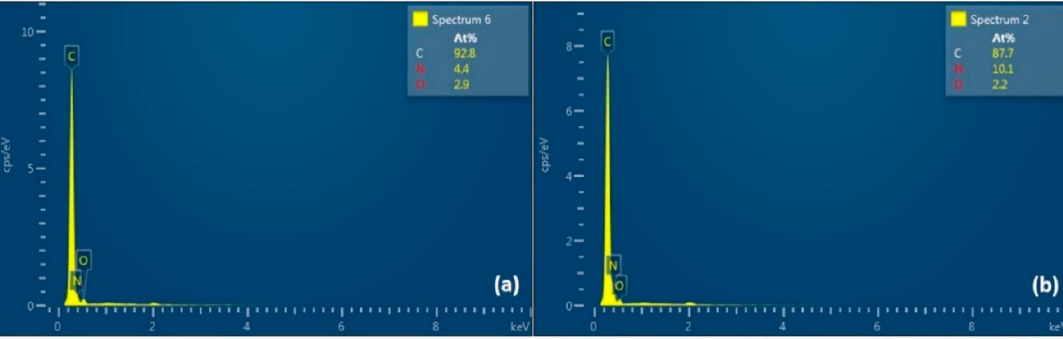
Figure 6. EDX spectra of ( a ) pristine ACNF and ( b ) rGO/ACNF composites.